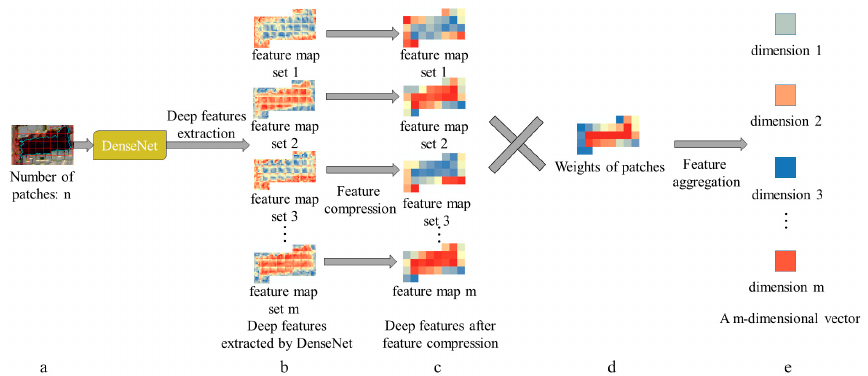
Figure 7. The flowchart of deep feature extraction for an image object: ( a ) the patch representation (patches are represented by red line while object boundaries are depicted in Cyan), ( b ) feature maps extracted by DenseNet (red color refers to high values and blue color represents low values), ( c ) feature maps after using compress function (mean operator), ( d ) the weights of patches, and ( e ) the final deep features of the image